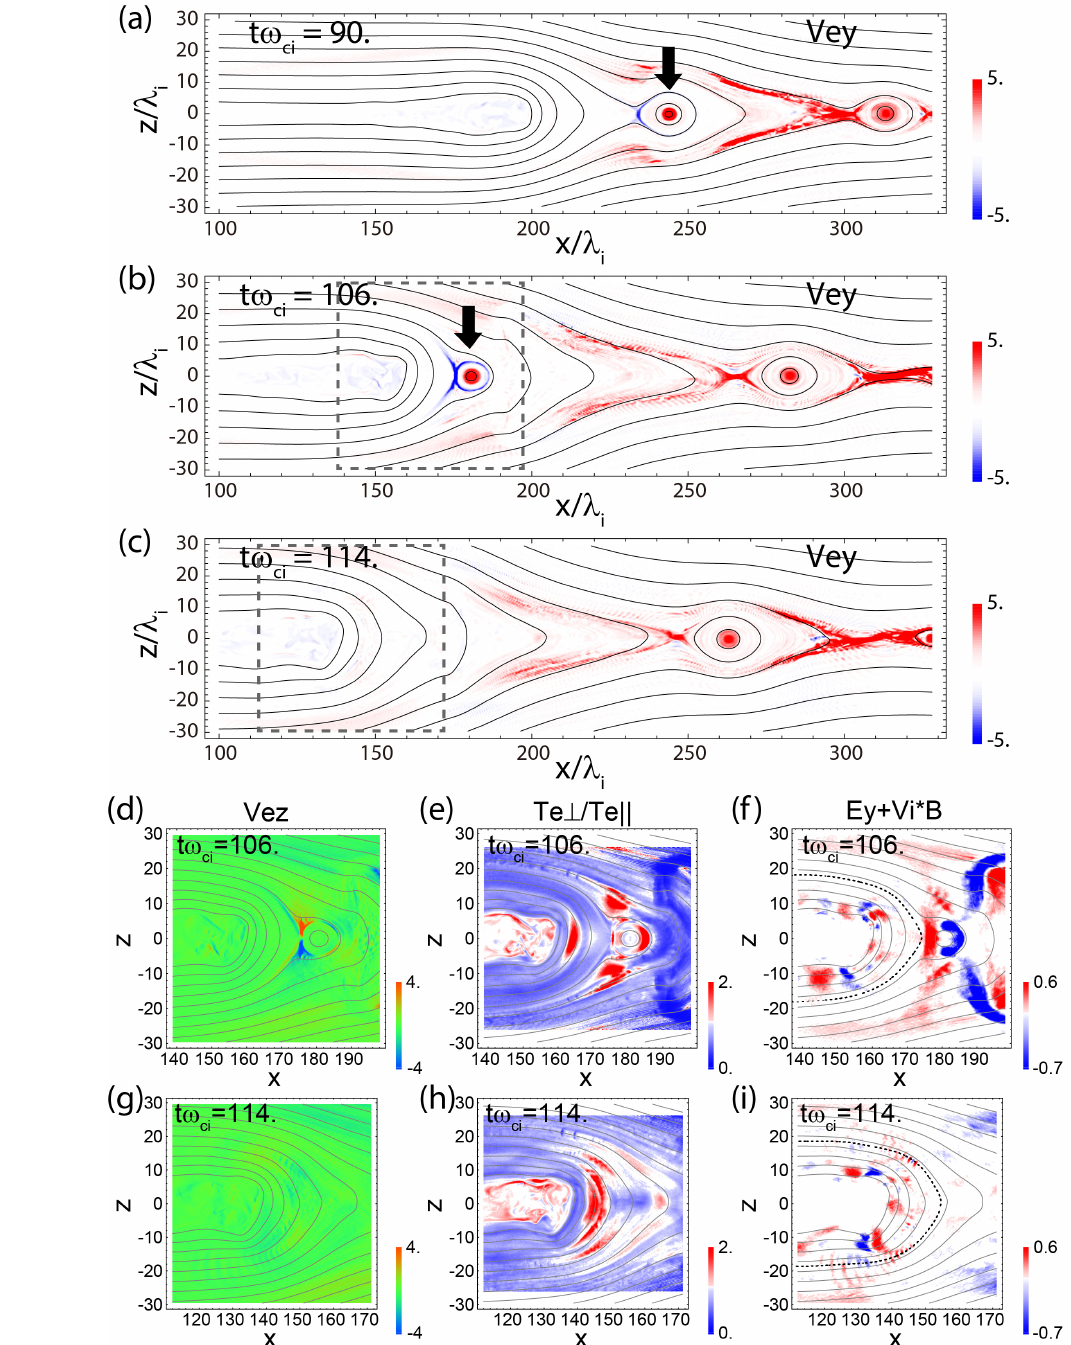
Figure 1. Time evolution of the main reconnection exhaust. (a–c) Two-dimensional snapshots of the out-of-plane electron bulk velocity at (a) tω ci = 90, (b) 106, and (c) 114. (d–f) Localized profiles at tω ci = 106 for (d) V e z , (e) T e ⊥ /T e (cid:107) , and (f) E y + (V i × B) y . (g–i) The same profiles as in (d–f) but in a different area at tω ci = 114. The black solid curves (a–c) and gray solid curves (d–i) represent the magnetic field lines, and the gray dashed boxes in (b) and (c) indicate the areas shown in (d–f) and (g–i) , respectively. The black dashed curves in (f) and (i) are the field lines traced at each time step from (x,z) = ( 0 , − 18 . 5 ) , a point far away from the areas in (f) and (i)